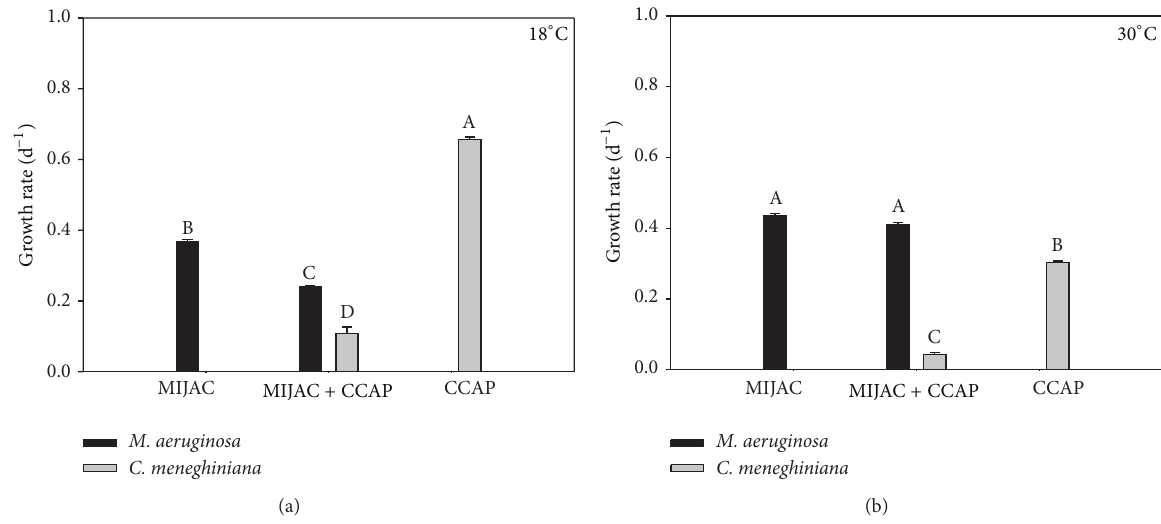
Figure 4: Chlorophyll- a -based growth rate of monocultures and mixed cultures of M. aeruginosa (MIJAC) and C. meneghiniana (CCAP) at two different temperatures (18 ∘ C and 30 ∘ C). Different letters represent significant differences at 𝑝 < 0.05